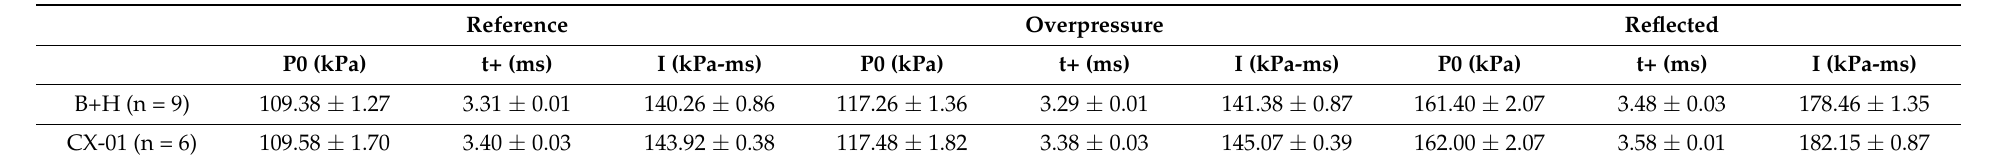
Table 1. Blast wave parameters. Legend: B + H group = blast + hemorrhage; CX-01 group = blast + CX-01; P0 (peak pressure) in kPa (the kilopascal, a unit